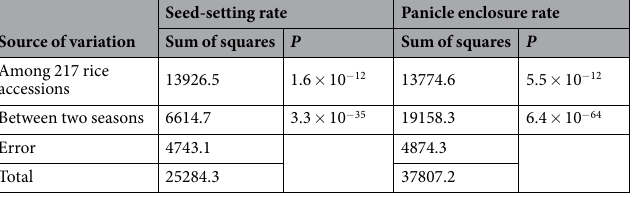
Table 2. Analysis of variance on the phenotypic performance of seed-setting rate and panicle enclosure